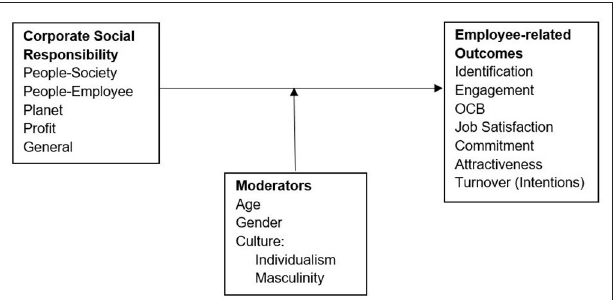
FIGURE 1 | Overview of constructs under investigation.